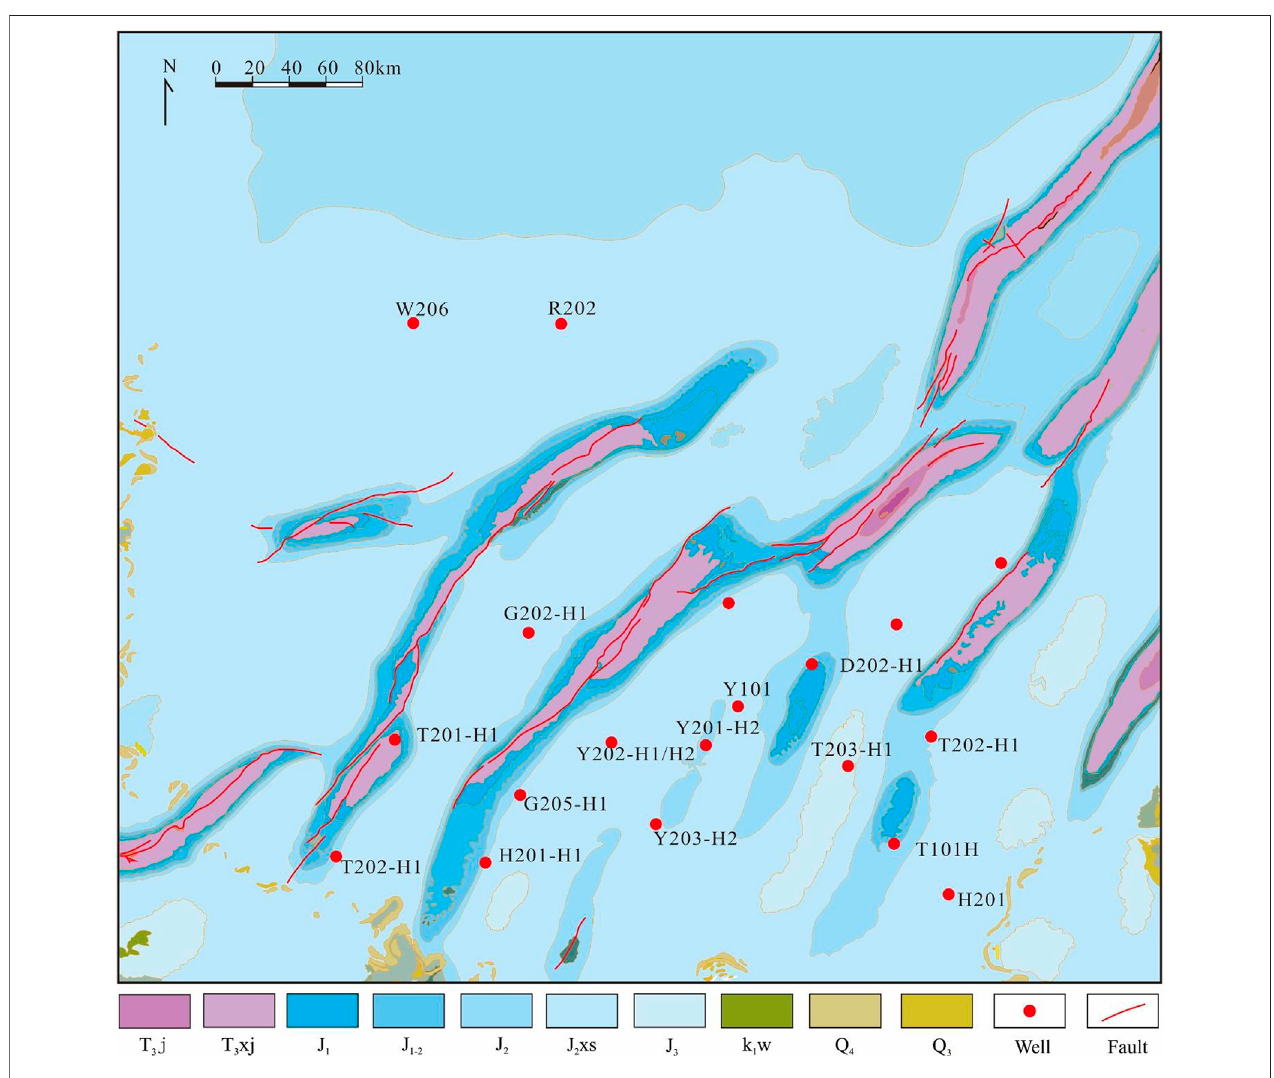
FIGURE 3 | Surface geological map of the Luzhou